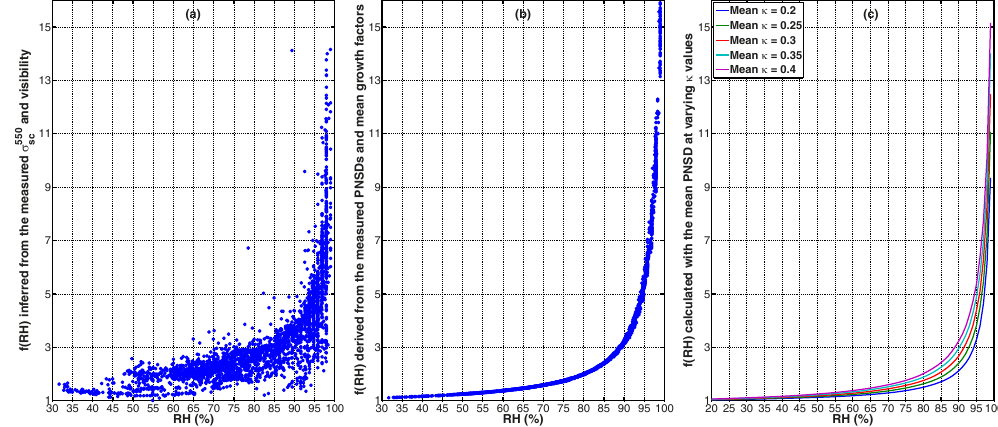
Figure 3. Sensitivity tests of (b) the PNSD and (c) hygroscopicity parameter κ to f (RH) based on in situ measured PNSDs and aerosol hygroscopic growth factors during the HaChi summer campaign. The subplot (a) represented the measured f (RH) derived from the in situ observations.